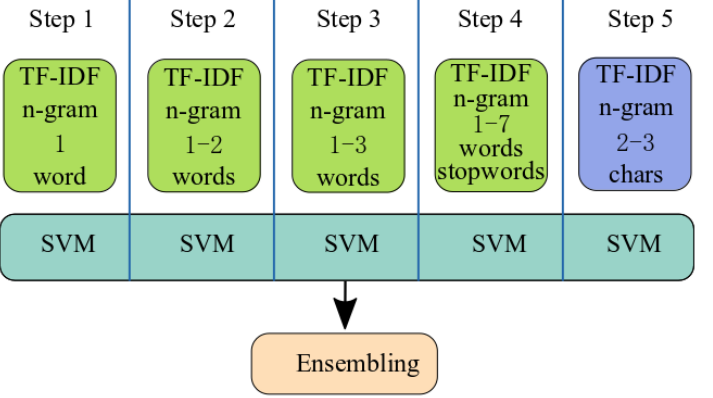
Figure 7. Text: Architecture of the SVM N-GRAMiterative